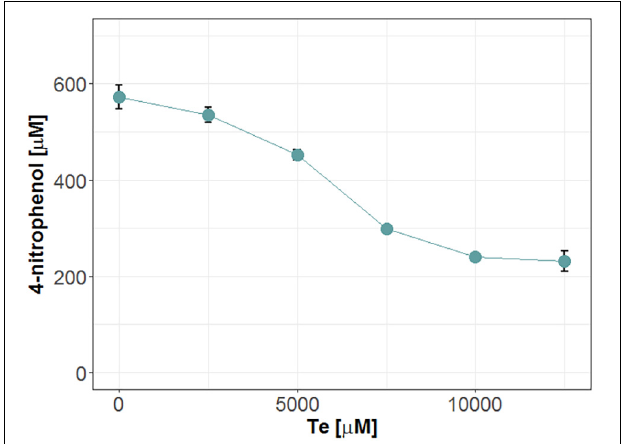
FIGURE 6 | Release of 4-nitrophenol after hydrolysis of MpNPT by Mle046 and in the presence of various concentrations of Te. Incubations were carried out for 30 min. Error bars indicate standard deviation ( n =